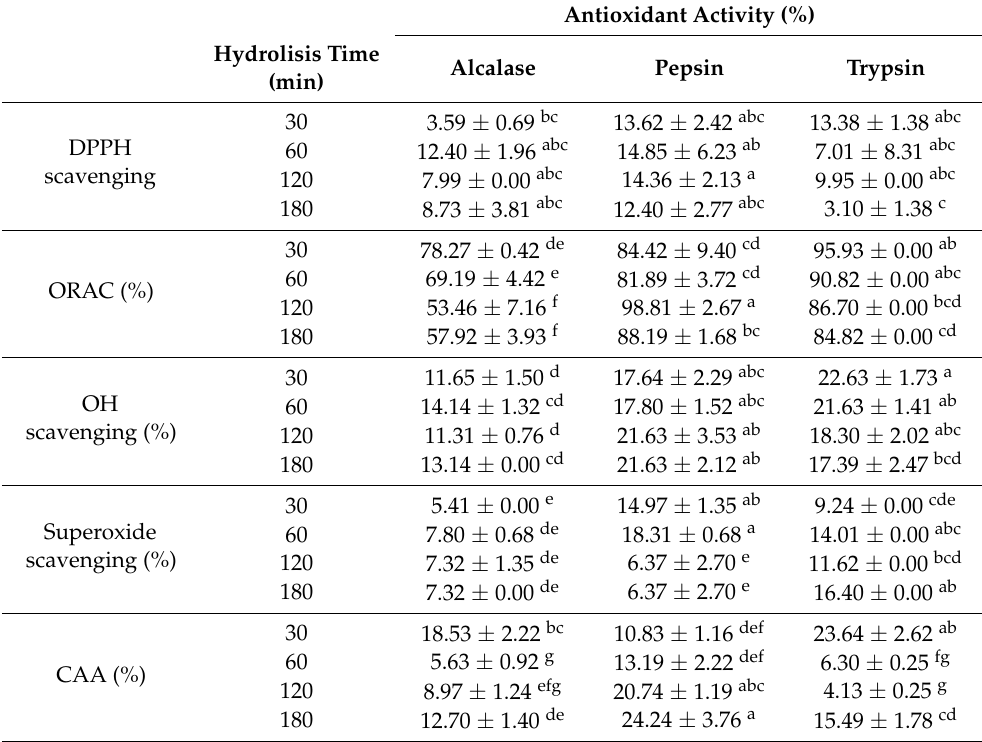
Table 3. Screening of antioxidant capacity of selenized hydrolysates cleavage with different enzymes (alcalase, pepsin, and trypsin) and times (30, 60, 120, and 180 min) of selenized hydrolysates from germinated chickpea at 25 µ